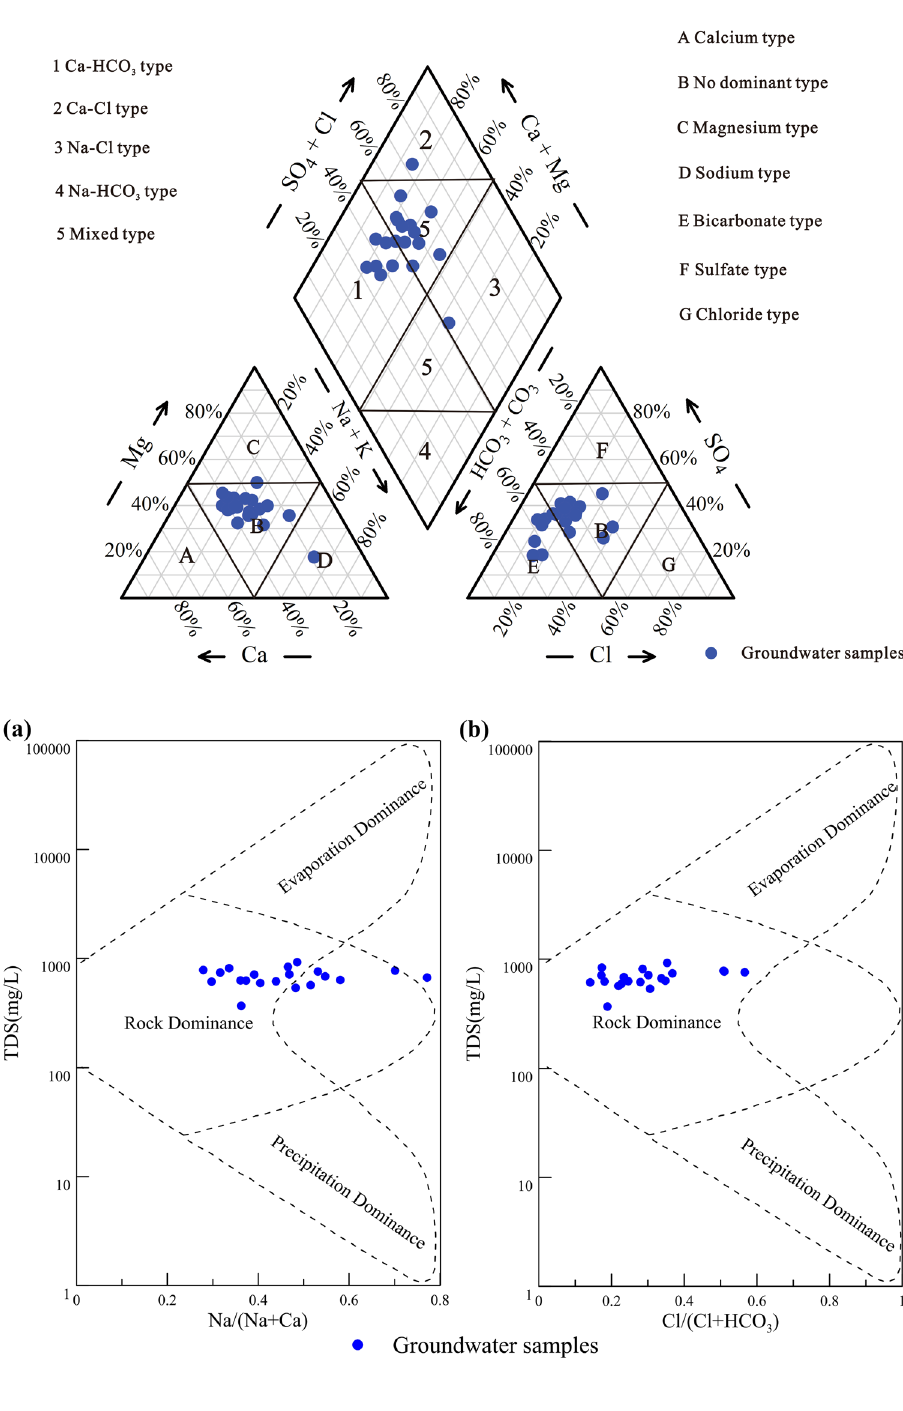
Fig. 3 Piper diagram for groundwater samples